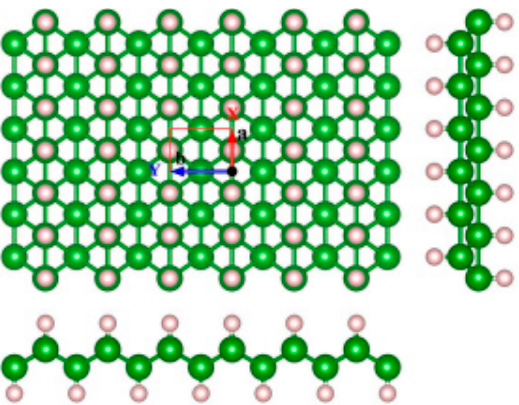
Figure 9. Top and side views of the optimized configuration of borophane. The unit cell is marked by a red box, in which the green and white balls respectively represent B and H atoms [64]. Copyright 2016, Royal Society of Chemistry.